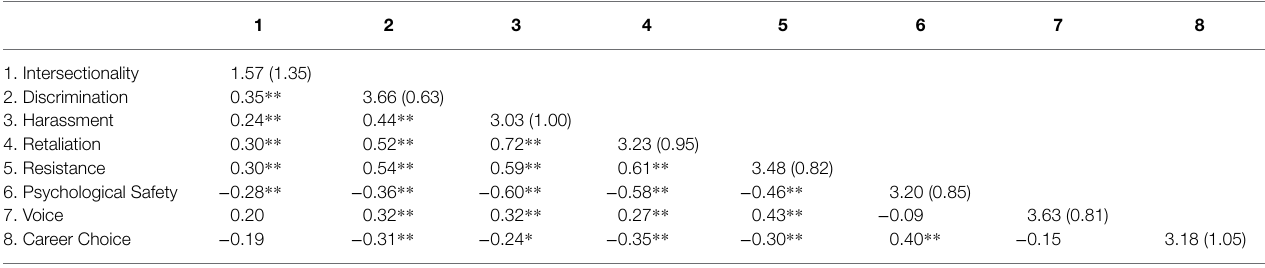
TABLE 1 | Means, standard deviations, and correlation coefficients.